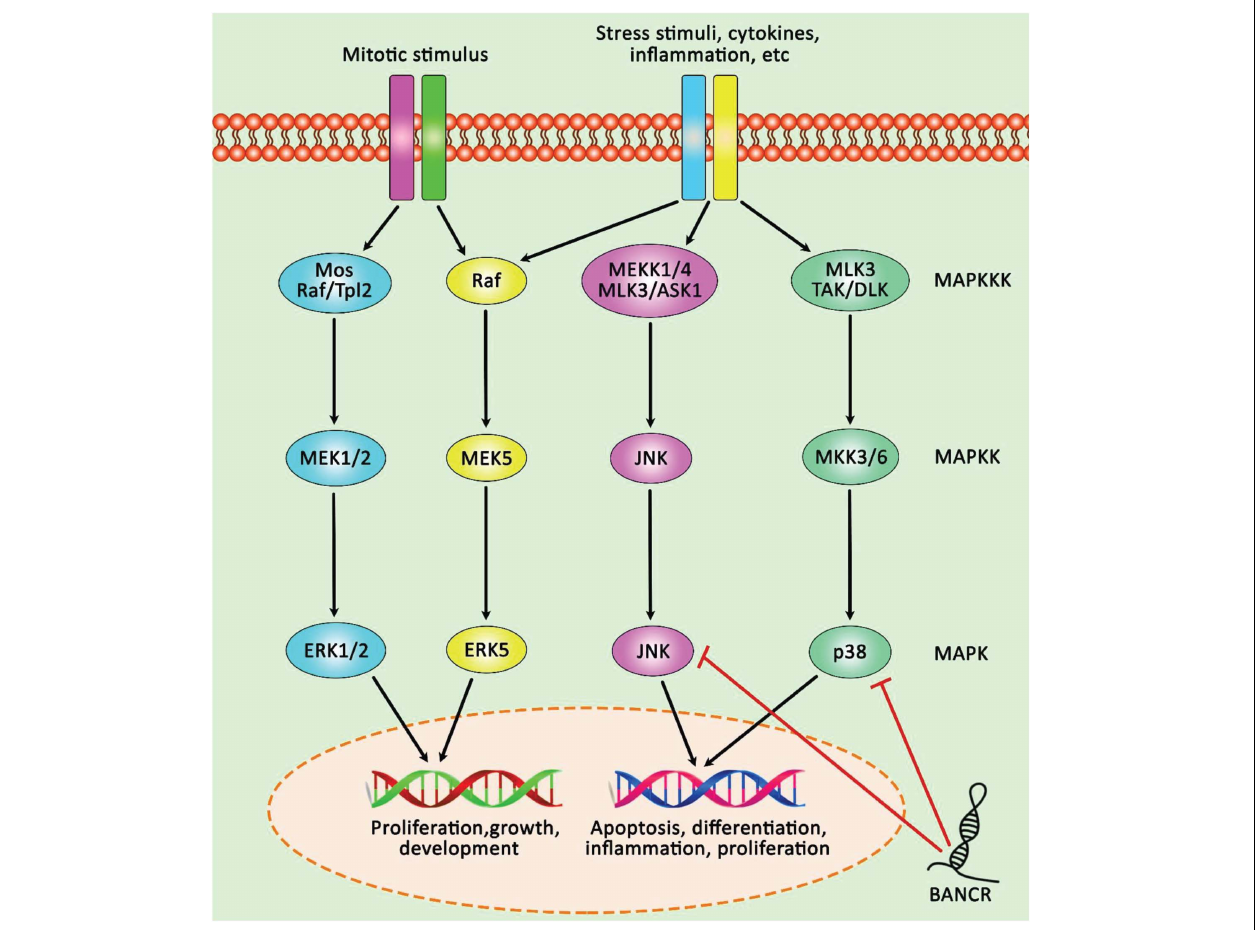
FIGURE 3 | A schematic illustration of tumor suppressive role of lncRNA BANCR in inhibiting proliferation and migration of lung carcinoma through MAPK pathways. LncRNA BANCR via suppressing the activation of p38 MAPK and JNK and modulating MAPK cascades could effectively reduce cell proliferation and migration of lung carcinoma (Jiang et al., 2015). Red arrows illustrate downregulation of target genes modulated via lncRNA BANCR.